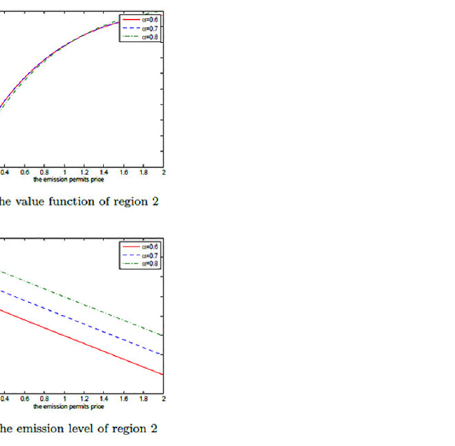
Fig 2. The effects of α on the noncooperative game.